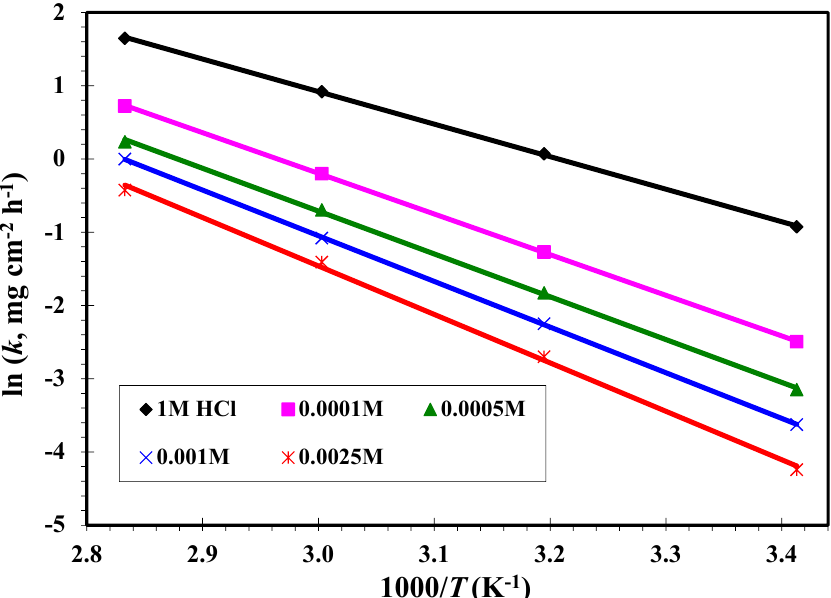
Figure 20. ln k versus 1/ T curves for MS dissolution in the absence and presence of different concentrations of CGSES12 in 1 M HCl solution.